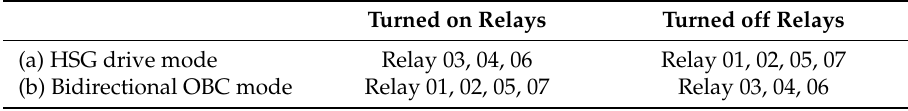
Table 3. The operation mode of the integrated circuit depending on the states of relays.